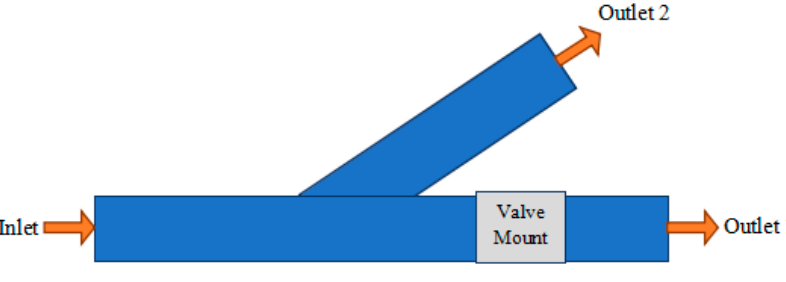
Figure 3. Flow diagram for compressed air.